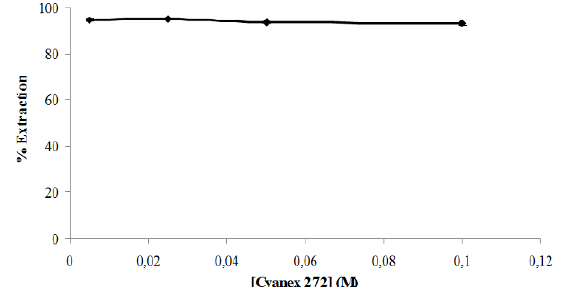
Figure 3. Variation of extraction efficiency (%) with Cyanex concentration in organic solution. Aqueous solution: